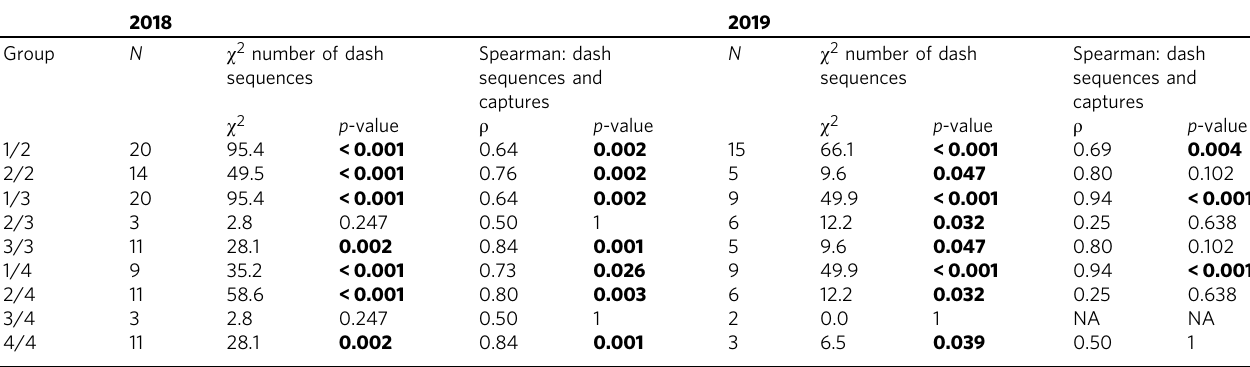
Table 1 Statistical results for dash and capture analysis.